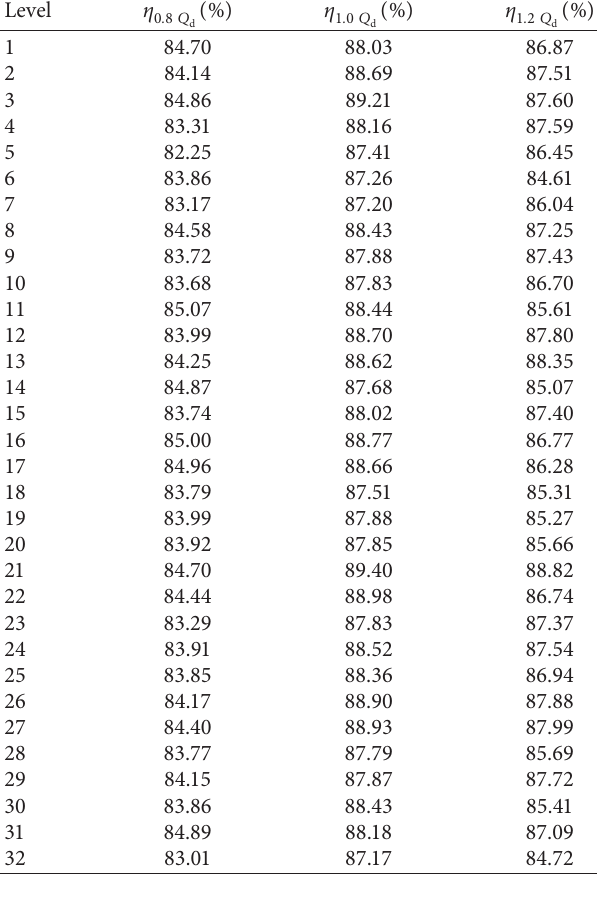
Table 4: Orthogonal test results.